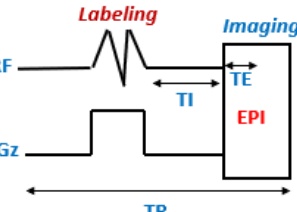
Figure 3. Schematic representation of the PASL sequence. EPI: echo planar imaging module; TE: echo time; TI: inversion time; TR: repetition time; G z : gradient.